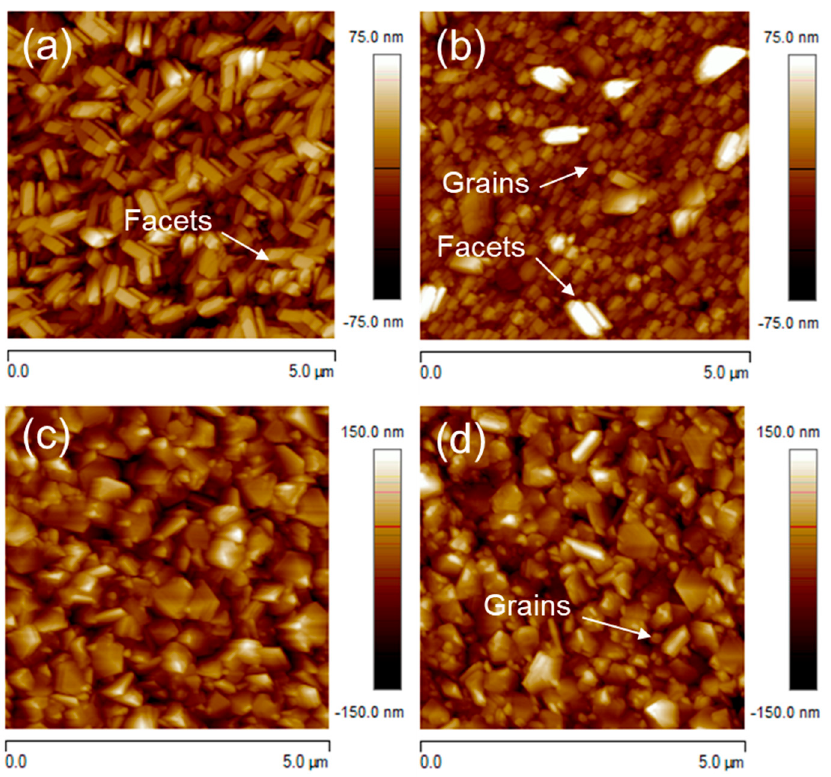
Figure 4. AFM size 5 µ m × 5 µ m scan of ( a ) Sample F (100 nm InGaN layer), RMS roughness: 18.3 nm, ( b ) Sample H (100 nm InGaN layer), RMS roughness: 14.5 nm, ( c ) Sample G (400 nm InGaN layer), RMS roughness: 30.8 nm, ( d ) Sample I (400 nm) InGaN layer, RMS roughness: 31.3 nm.